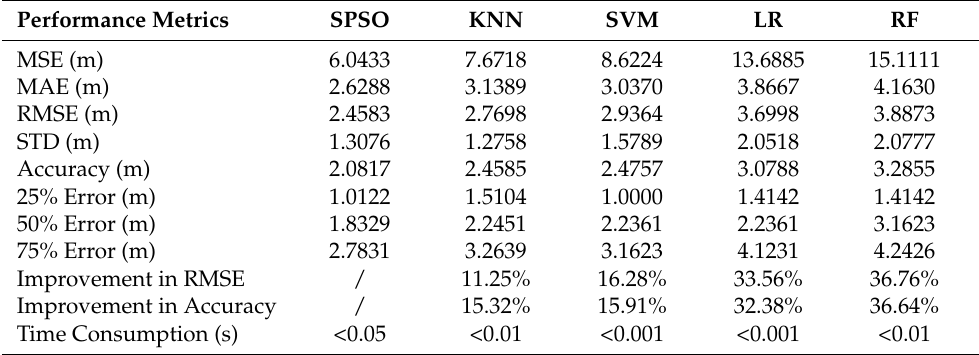
Table 2. The performance metrics of different localization